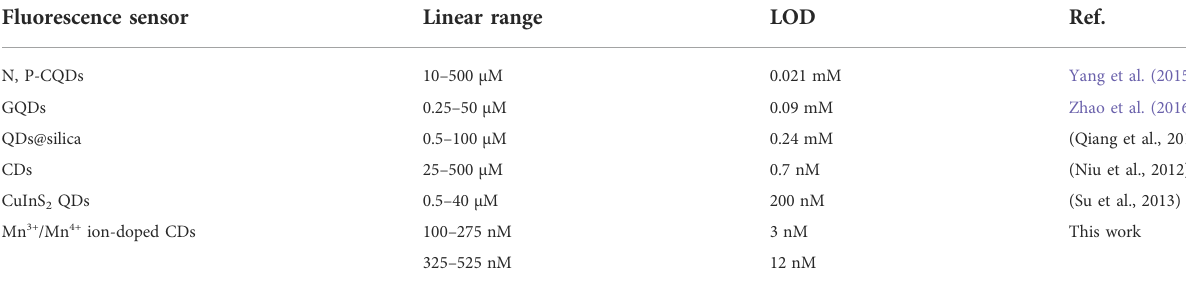
TABLE 1 The comparison of this method with other DA detection in